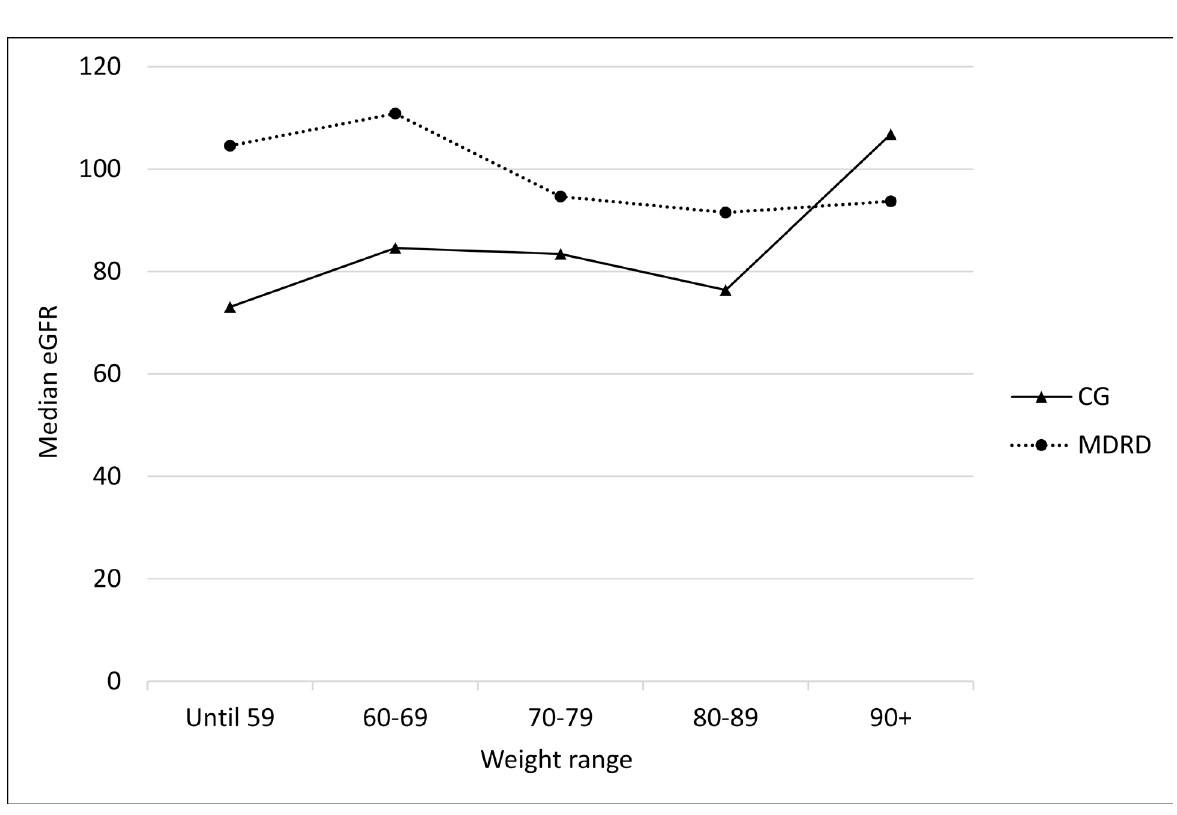
Figure 2 - Median estimated glomerular filtration rate calculated using MDRD-4 or Cockcroft-Gault versus weight